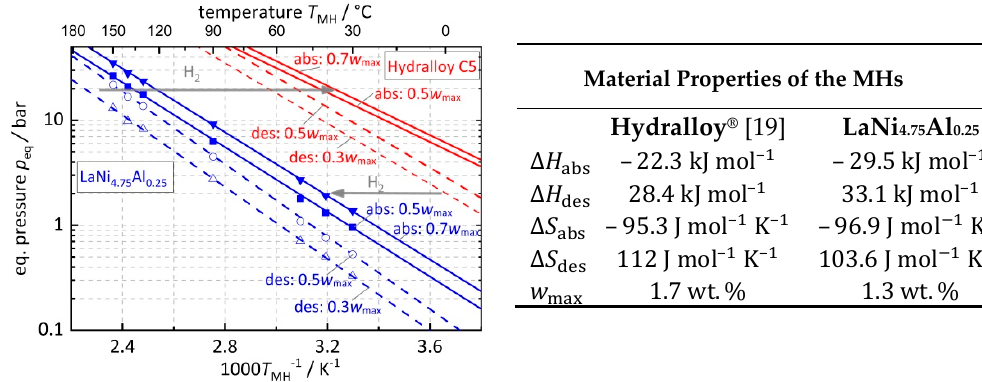
Figure 2. Left: Van’t-Hoff plot of Hydralloy ® C5 [19] and LaNi 4.75 Al 0.25 (own data) for various hydrogen capacities. The operation is indicated by the grey hydrogen arrows. Right: material properties for 0.5 ∙ 𝑤 max .